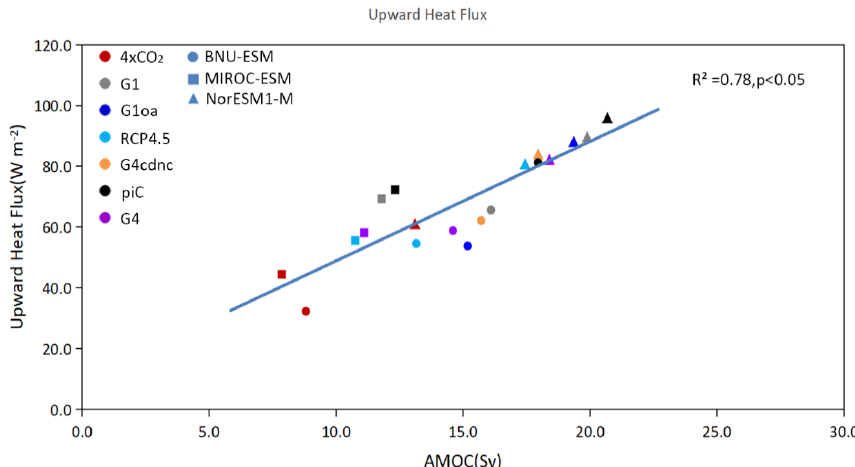
Figure 8. Model mean of upward heat flux (Wm − 2 ) over the 40-year analysis period in the three deep convective regions outlined in Fig. 6. Only heat flux data from BNU-ESM, MIROC-ESM and NorESM1-M are available. All three ESMs show a high correlation between upward heat flux (area average of the deep convective regions) and AMOC intensity. The solid line is the linear regression trend line of AMOC intensity and upward heat flux (area average of the deep convective regions) over the 40-year analysis period.